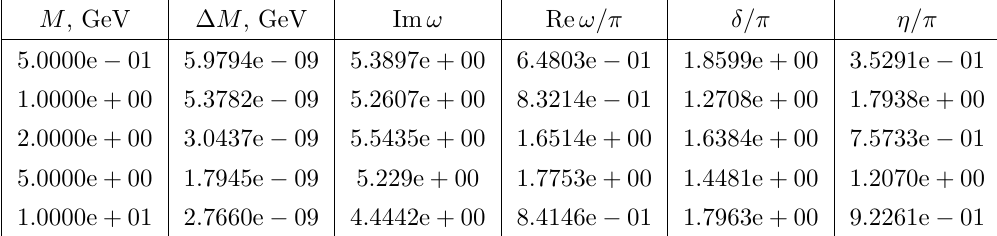
Table 4 . Parameter sets leading to the observed value of the BAU, NH case.